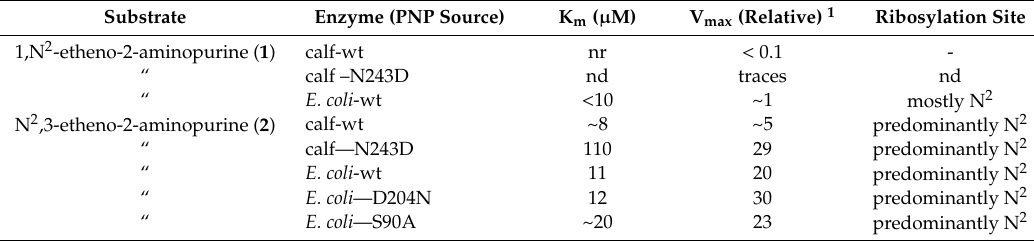
Table 3. Kinetic parameters for the enzymatic ribosylation of selected etheno-purine derivatives in 40 mM HEPES bu ff er, pH 7, by α - d -ribose-1-phosphate, using various forms of PNP (wt = wild